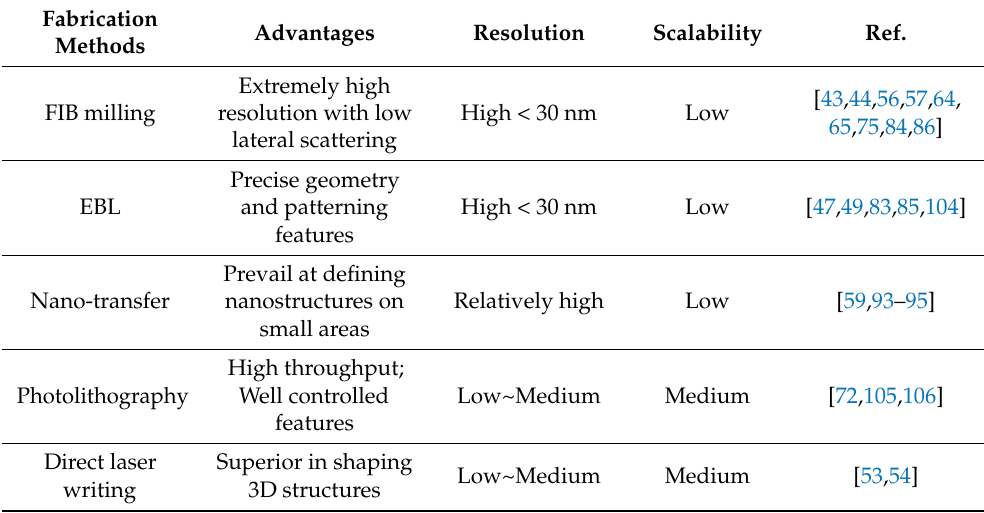
Table 1. Summary of fabrication methodologies related to optical fiber